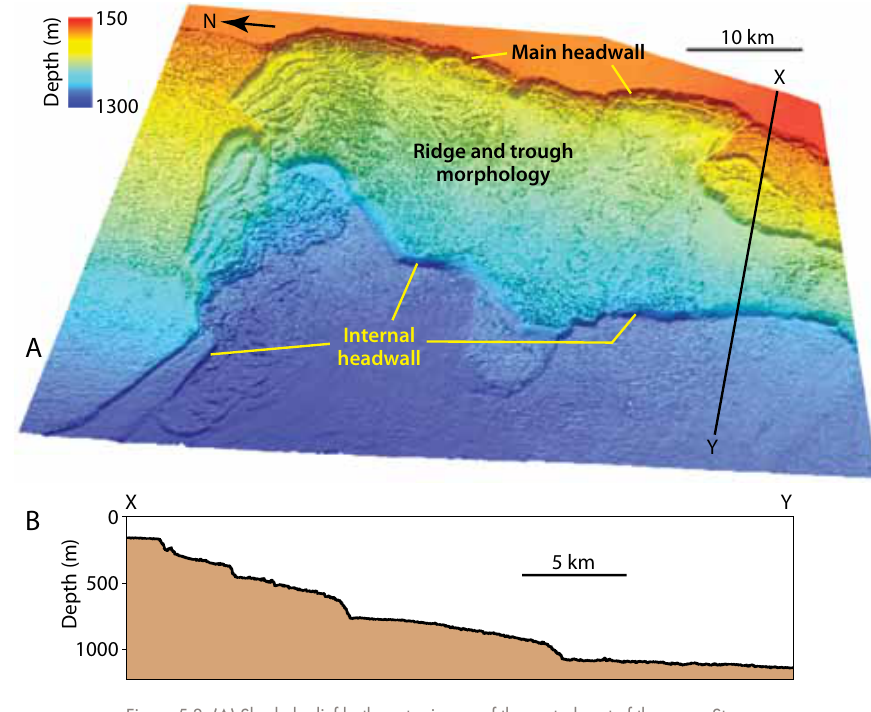
figure 5.3. (a) shaded relief bathymetry image of the central part of the upper storegga slide, a huge landslide that unleashed a major tsunami offshore norway. (B) depth profile across the slide. from masson et al. (2010), figure 1. reprinted with kind permission from springer science+Business